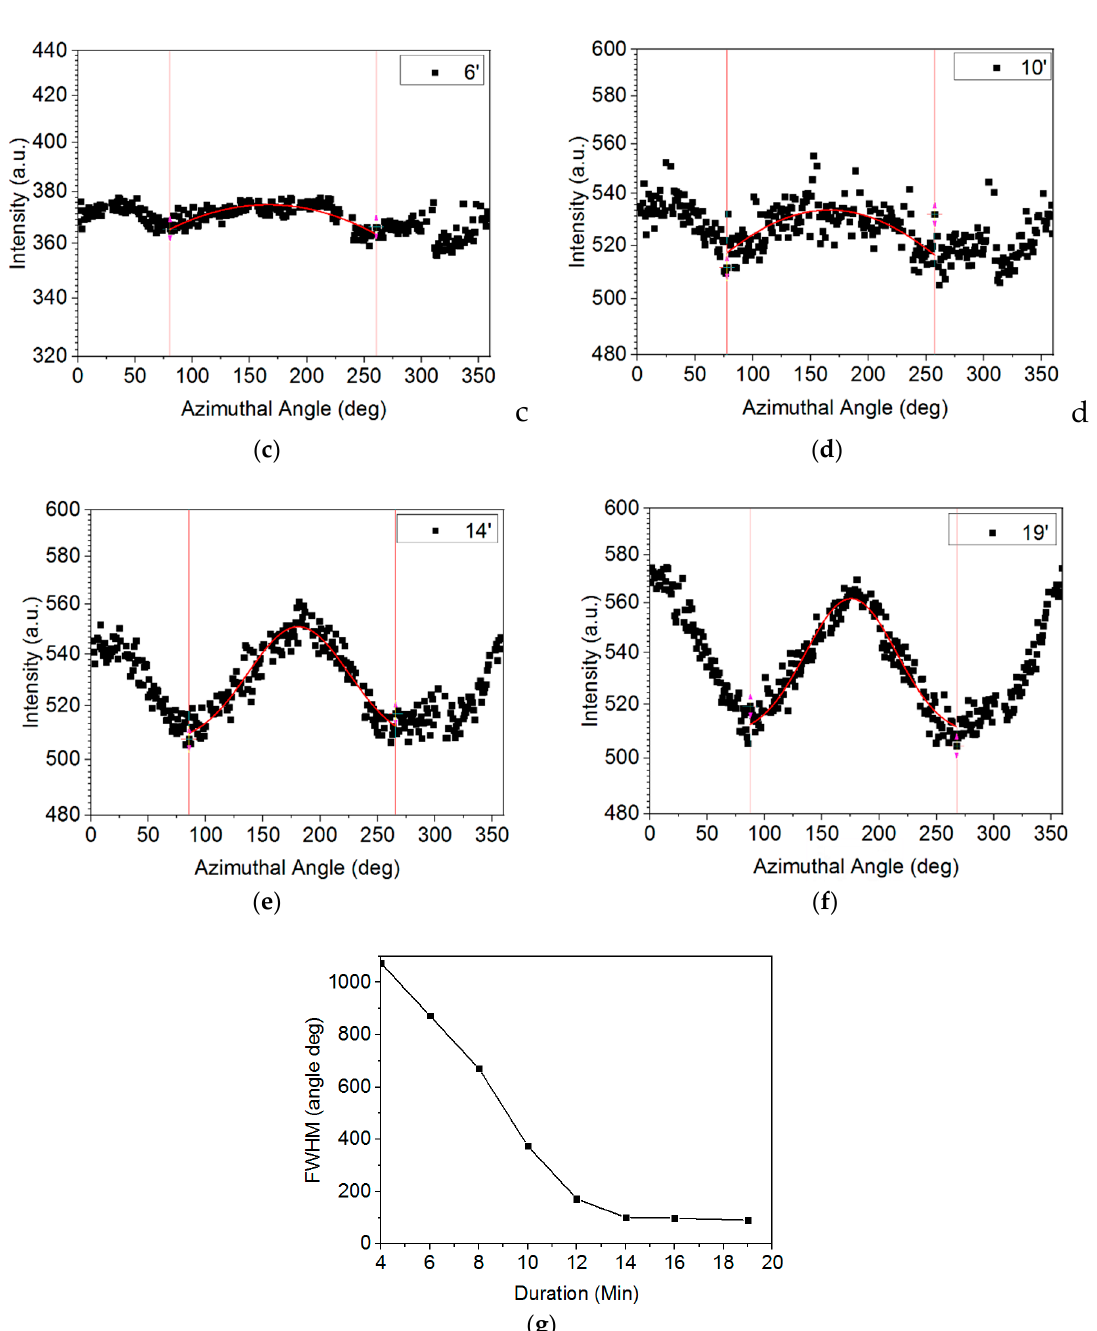
Figure 3. Illustration of the alignment and in-situ synchrotron SXAS results of magnetic nanoparticle doped hexagonal phase aligned with magnetic field. ( a ) Polydomain structure of magnetic nanoparticles doped hexagonal phase; ( b ) Magnetically-aligned hexagonal phase; ( c – f ) Corresponding azimuthal intensity of the primary Bragg peak for hexagonal phase aligned at 6, 10, 14, 19 min, respectively; and ( g ) FWHM of azimuthal intensity of in-situ measurement versus time of sample in the magnetic field.